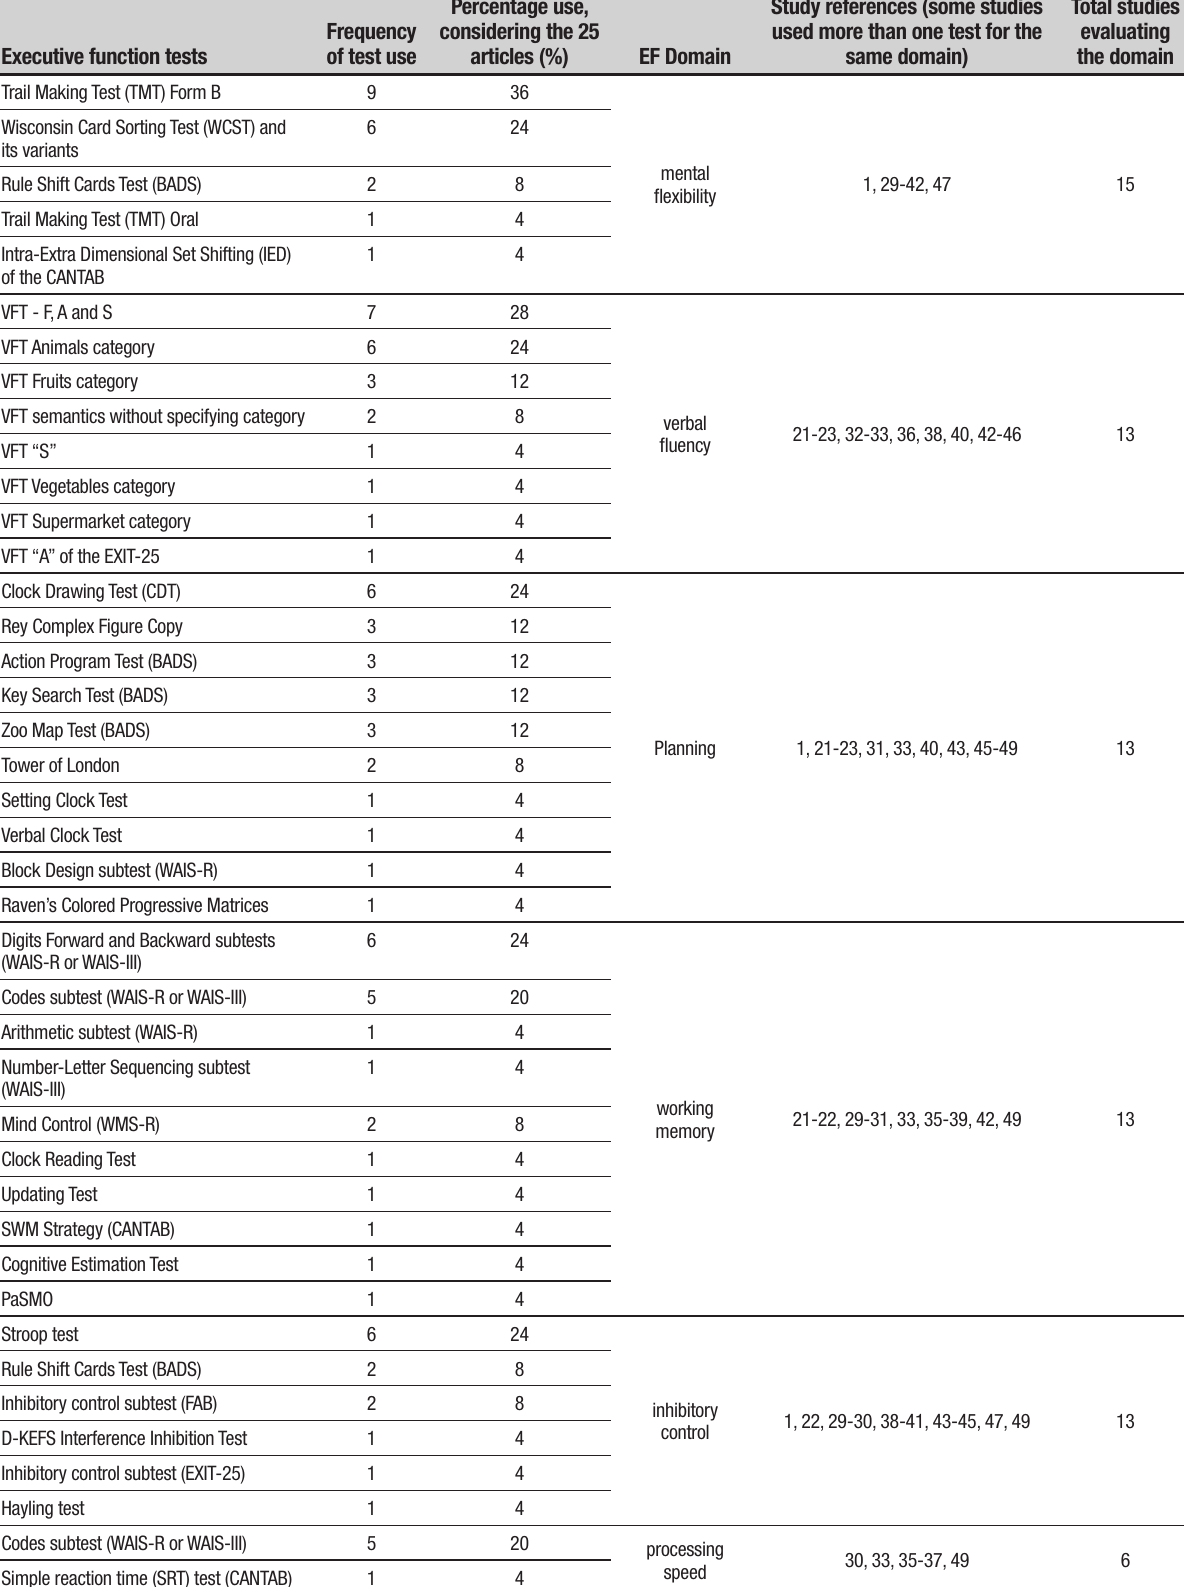
Table 2. Frequency of use of executive function tests in aging research. Executive function tests